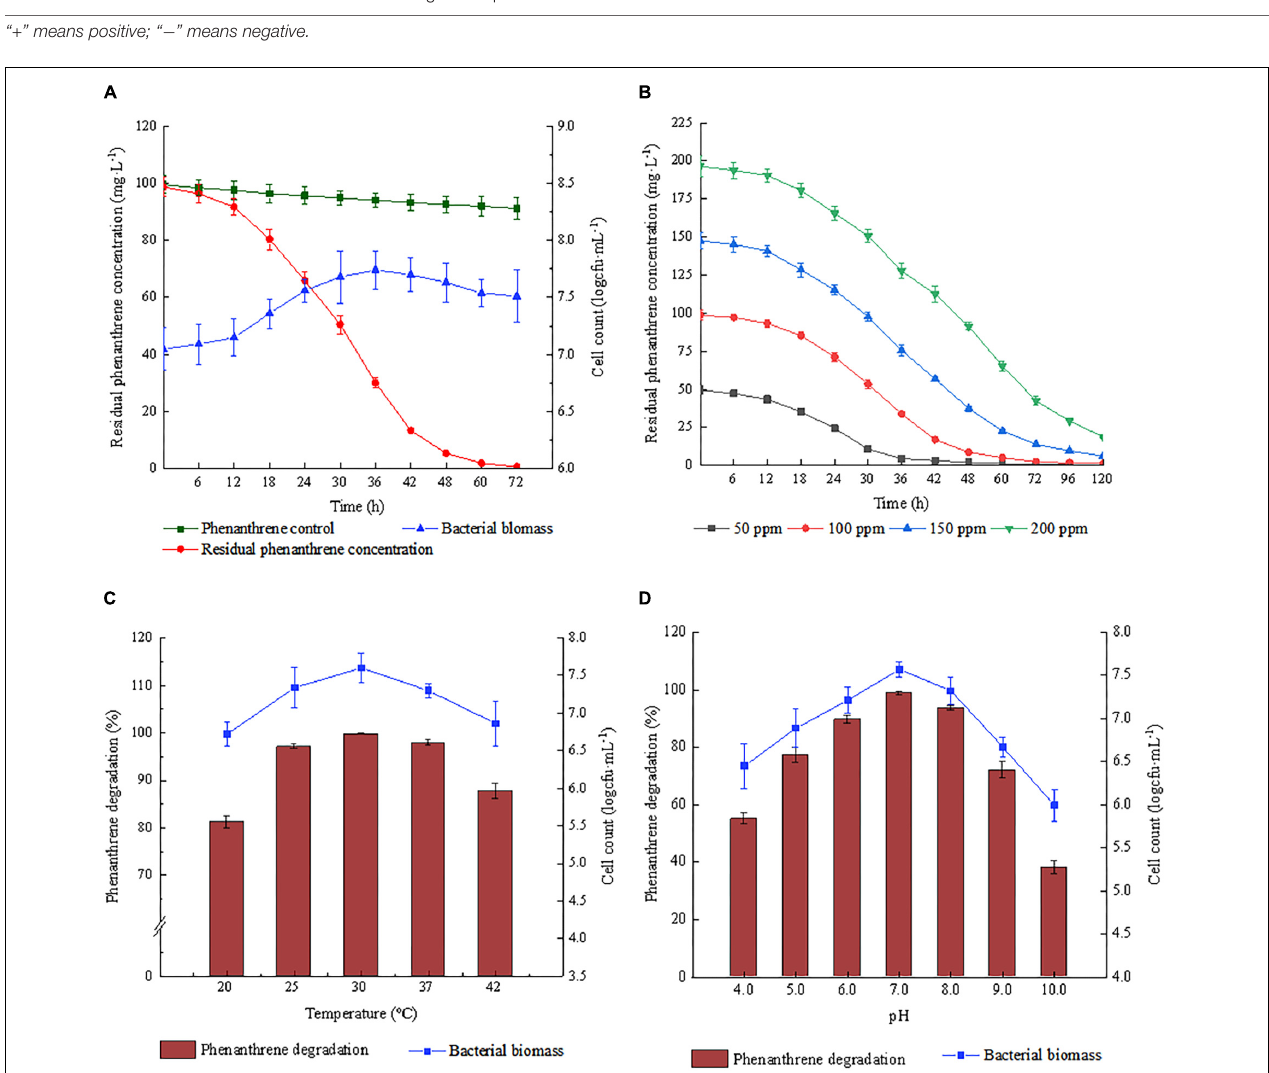
FIGURE 2 | Degradation of phenanthrene by strain Phe15. (A) Degradation dynamics of phenanthrene and the growth curve of strain Phe15; (B) Effect of substrate concentration on phenanthrene degradation by strain Phe15; (C) Effect of temperature on phenanthrene degradation and cell growth of strain Phe15; (D) Effect of initial pH value on phenanthrene degradation and cell growth of strain Phe15. Error bars are standard deviations (SD), n =